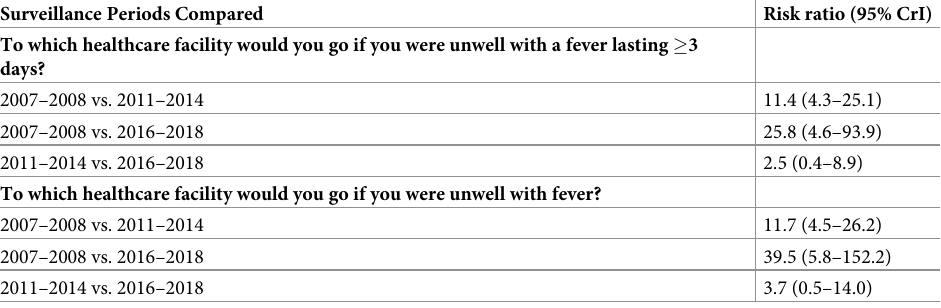
Table 6. Typhoid fever incidence risk ratio pair-wise comparisons for each surveillance period, Kilimanjaro Region, Tanzania, 2007–2018. Surveillance Periods Compared